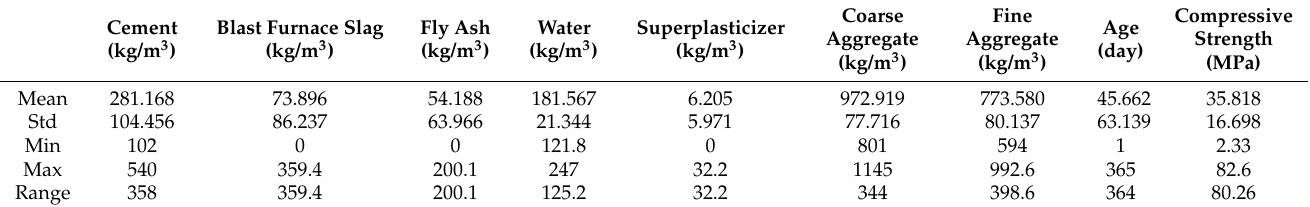
Table 1. Statistical properties of Yeh’s dataset